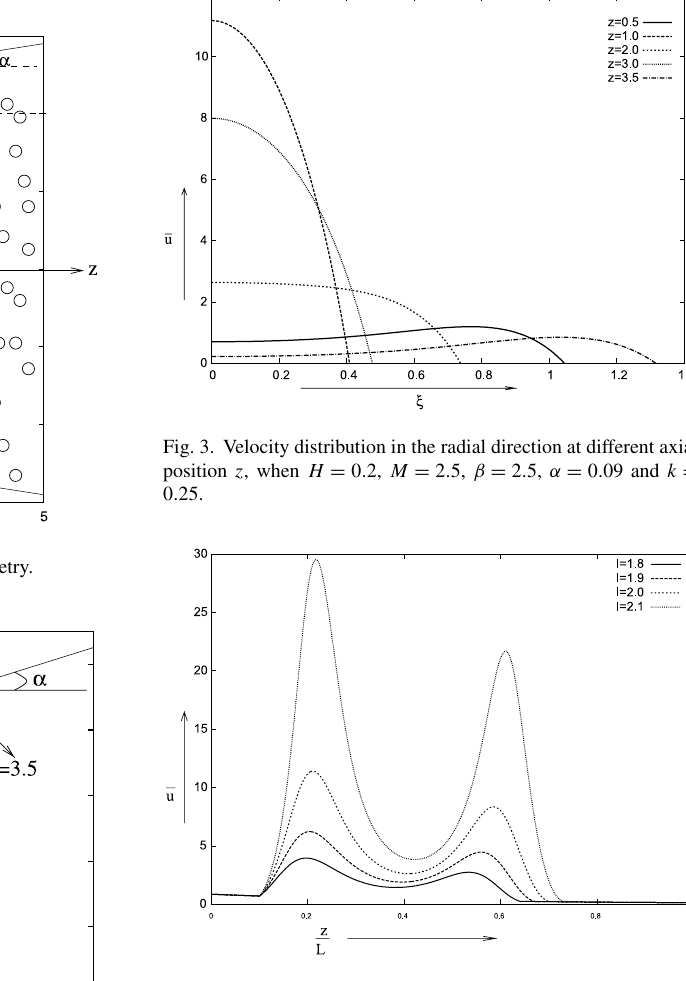
Fig. 4. Variation of axial velocity along axial direction for different values of l , when H = 0 . 2, M = 2 . 5, α = 0 . 09 and k = 0 .